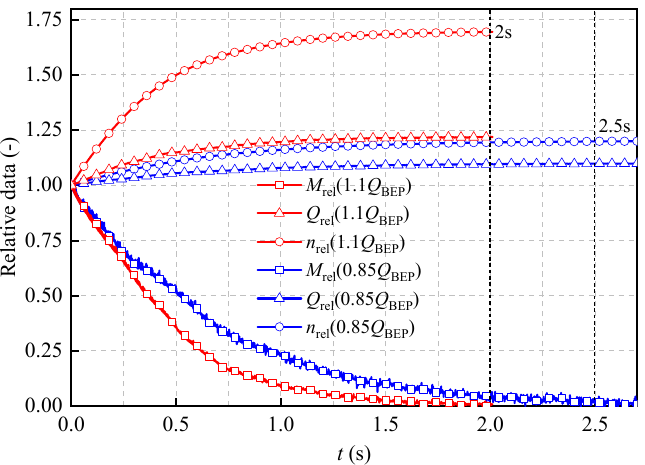
Figure 11. Comparison of the working parameters in the runaway process of the turbine.